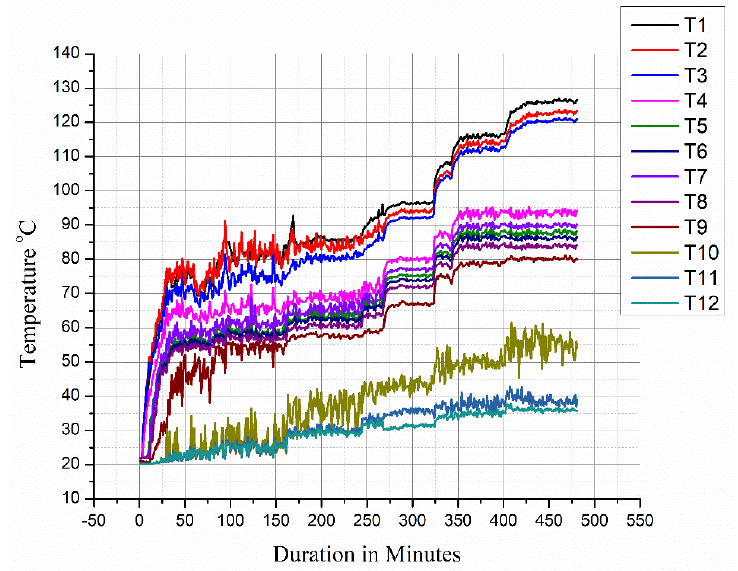
Figure 5. Attainment of the steady-state condition by the thermocouples.